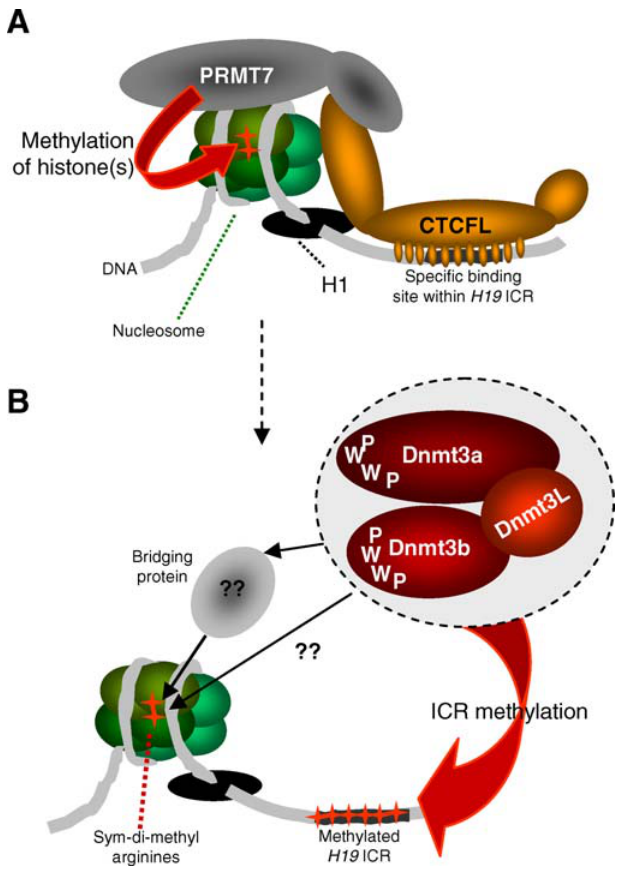
Figure 8. Model of H19 ICR